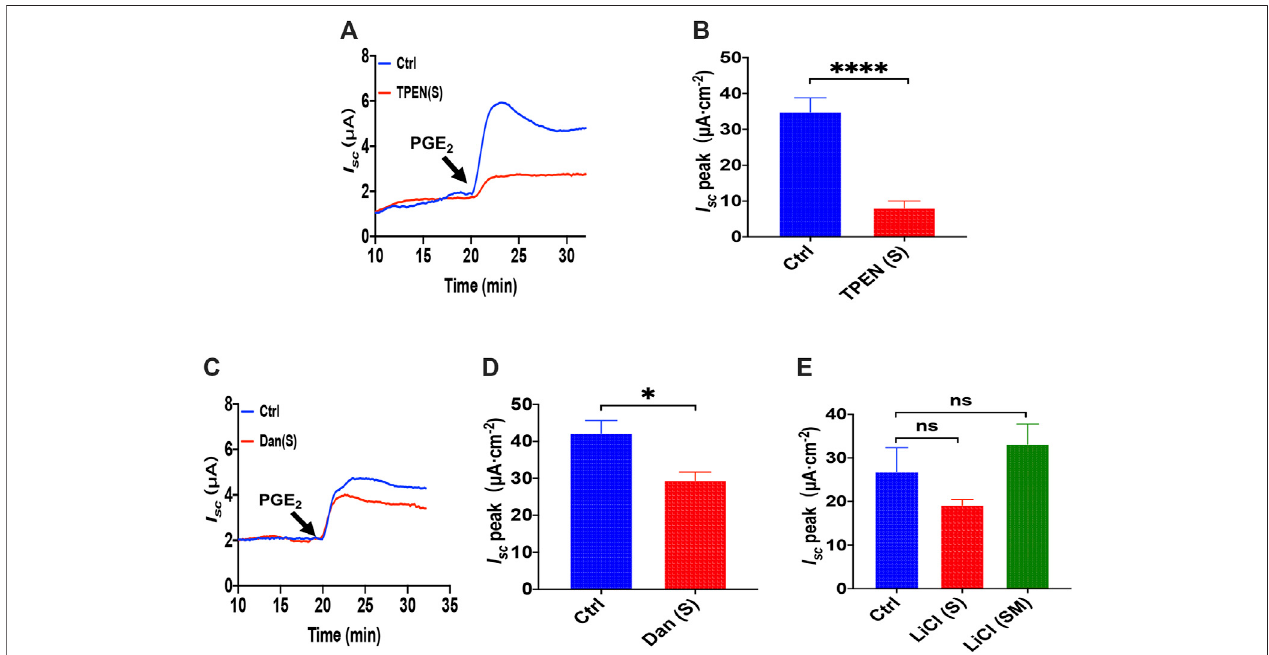
FIGURE 3 | The ER Ca 2+ store and ryanodine receptors in PGE 2 -induced duodenal ion transports. (A,B) PGE 2 (10 μ M) -evoked I sc after serosal (s) application of TPEN (1 mM, n (cid:2) 6). (C,D) PGE 2 -evoked I sc after dantrolene (Dan, 300 μ M, n ≥ 6) wasadded totheserosal (s). (E) PGE 2 -evoked I sc after LiCl(30 mM, n ≥ 6) wasadded totheserosalsideorbothsides(m+s).Ctrlrepresentsthecontrolwithoutdrugtreatment.Resultsarepresentedasmean ± SE.NS,nosigni fi cantdifferences,* p < 0.05, **** p < 0.0001 vs. corresponding control by Student ’ s unpaired, two-tailed t-test or one-way ANOVA followed by Dunnett ’ s